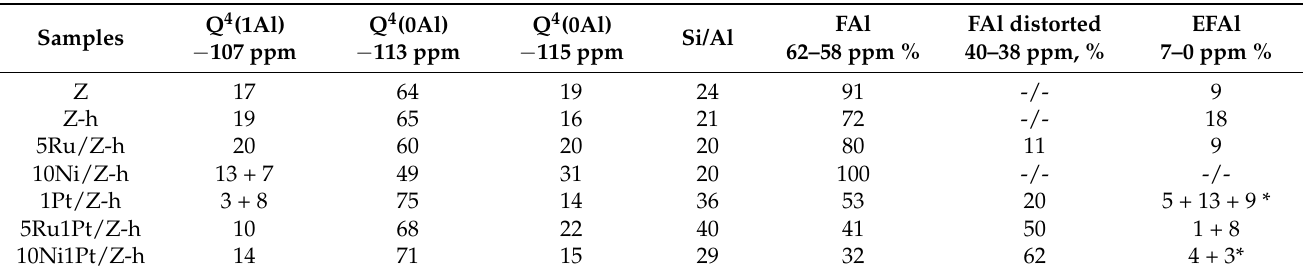
Table 2. Area of the signals of the different Si and Al species, obtained by deconvolution of the spectral patterns in the 29 Si and 27 Al spectra.